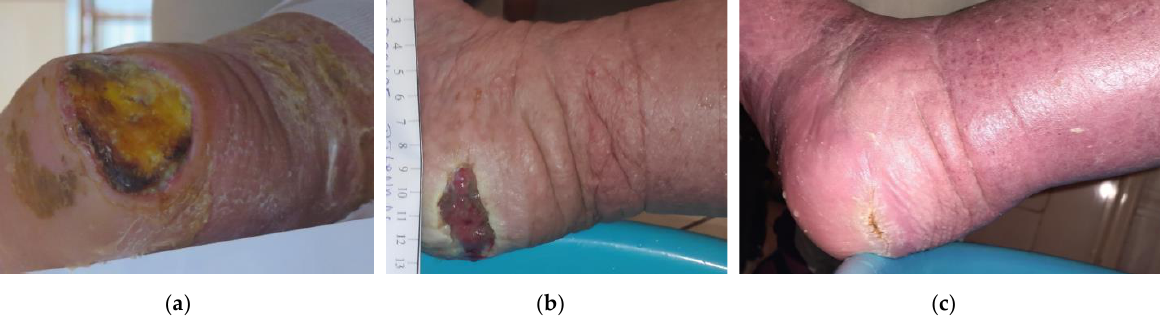
Figure 9. Case 9: ( a ) clinical findings at initial examination, day 0 (start of MGH treatment); ( b ) MGH products induced autolytic debridement and promoted wound healing after 4 weeks of treatment; ( c ) complete wound healing after 20 weeks of MGH therapy.